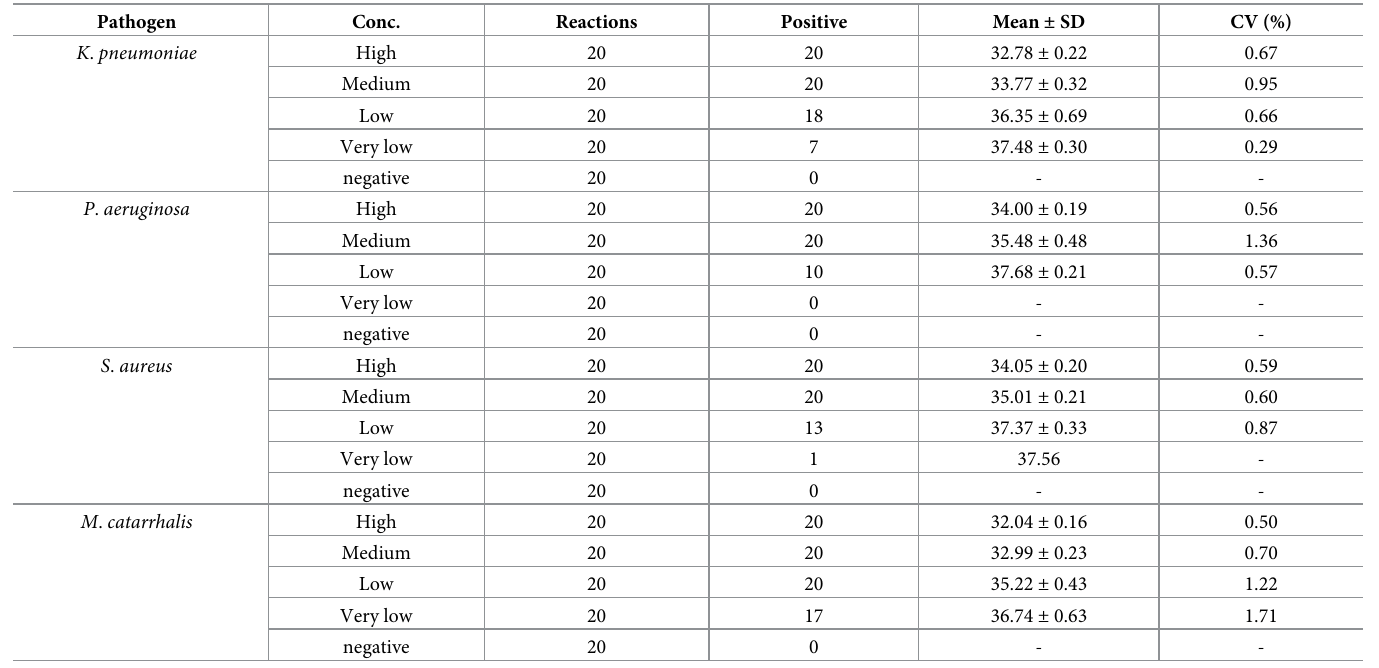
RB4 mRT-PCR reactions performed using positive controls in the amount of 10 3 , 5 × 10 2 , 10 2 , and 5 × 10 1 copies/reaction corresponding to high, medium, low, and very low concentrations, respectively.